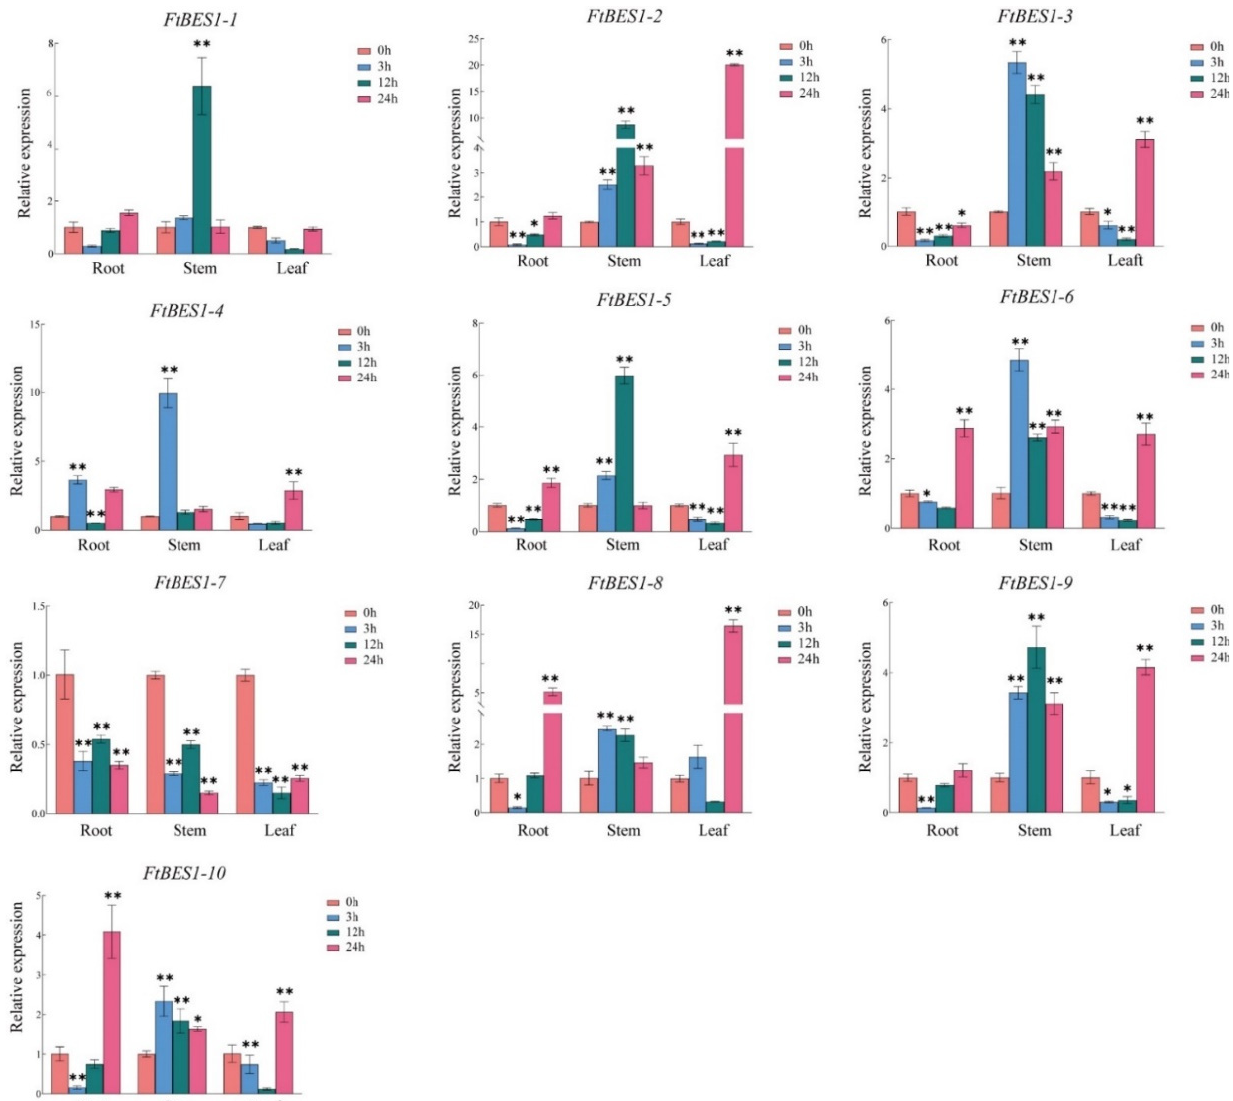
Figure 6. Expression levels of FtBES1 gene in different tissues after 100 μ M ABA treatment. Different colors indicate different times of stress treatment. Three biological replicates were considered for each experiment. Error lines indicate standard errors of three independent biological replicates. * In the figure indicates significant differences calculated by t -test (* p < 0.05, ** p <